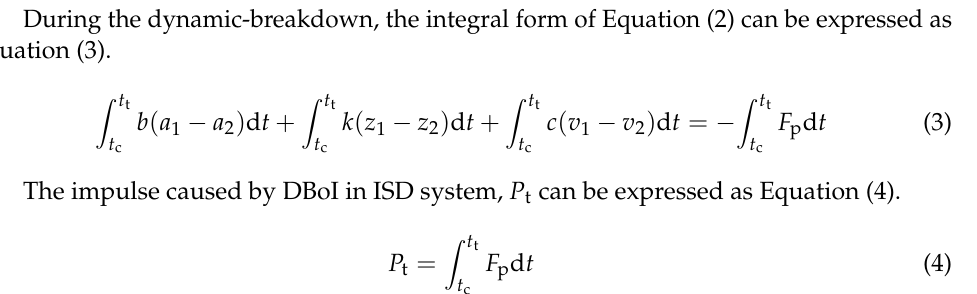
Figure 2. Dynamic model of the DBoI in a typical ISD system. ( a ) Before dynamic-breakdown; ( b ) During dynamic-breakdown.